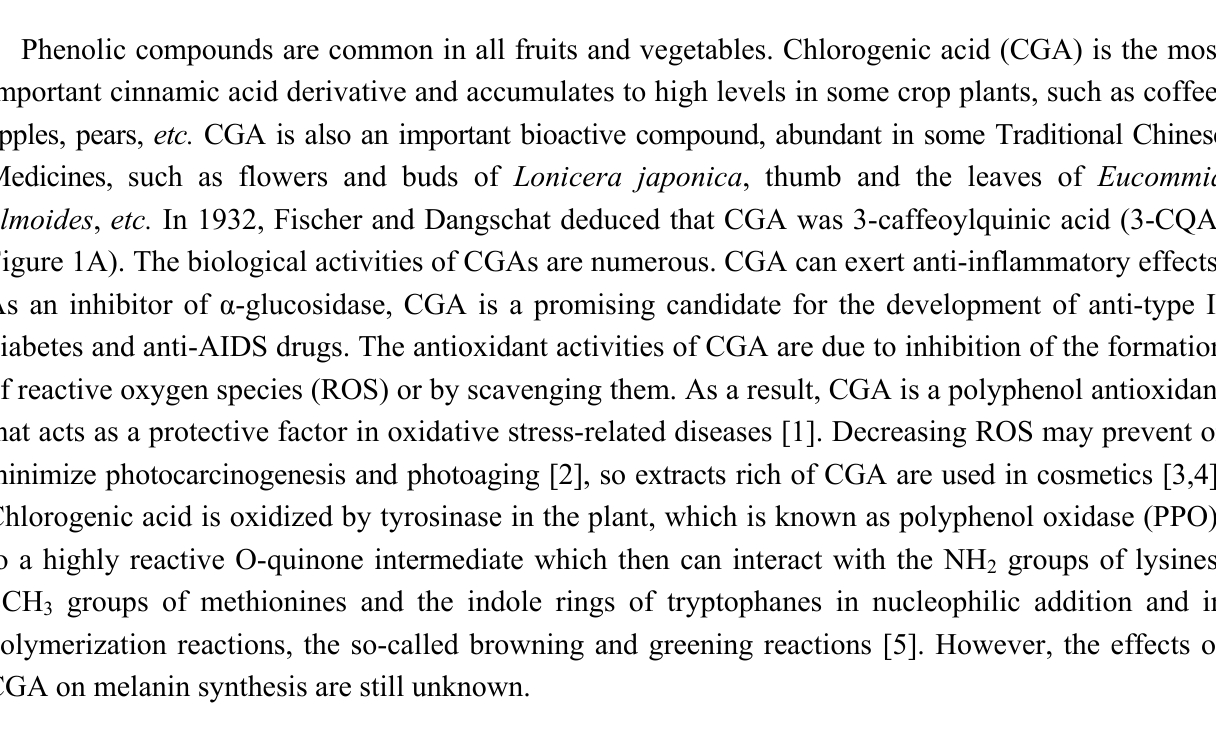
Figure 1. The chemical structures of chlorogenic acid, tyrosine and L